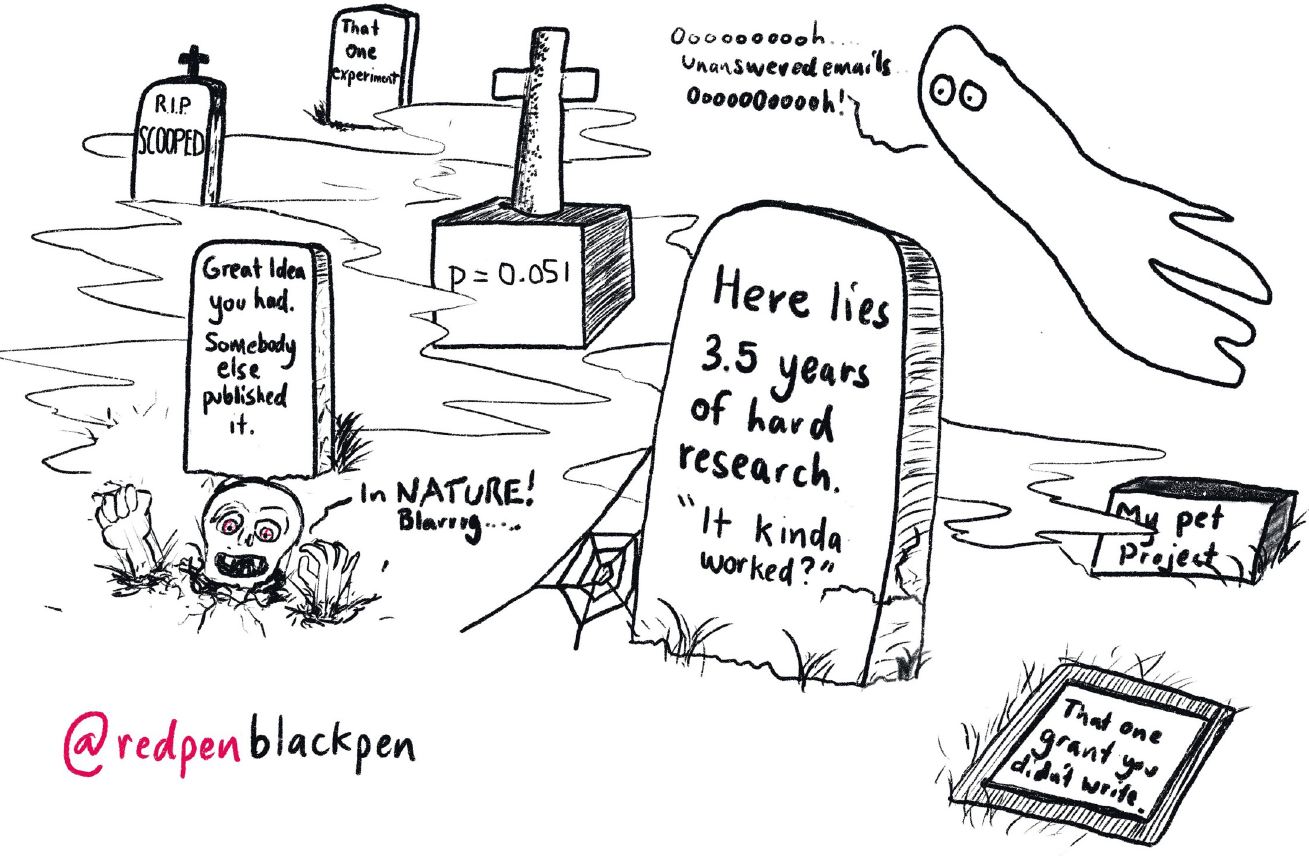
Fig 3. Publish papers. Every successful PI has a “graveyard” of uncompleted and/or unsuccessful ideas. The trick is to have a lot of things going forward to make sure some survive.